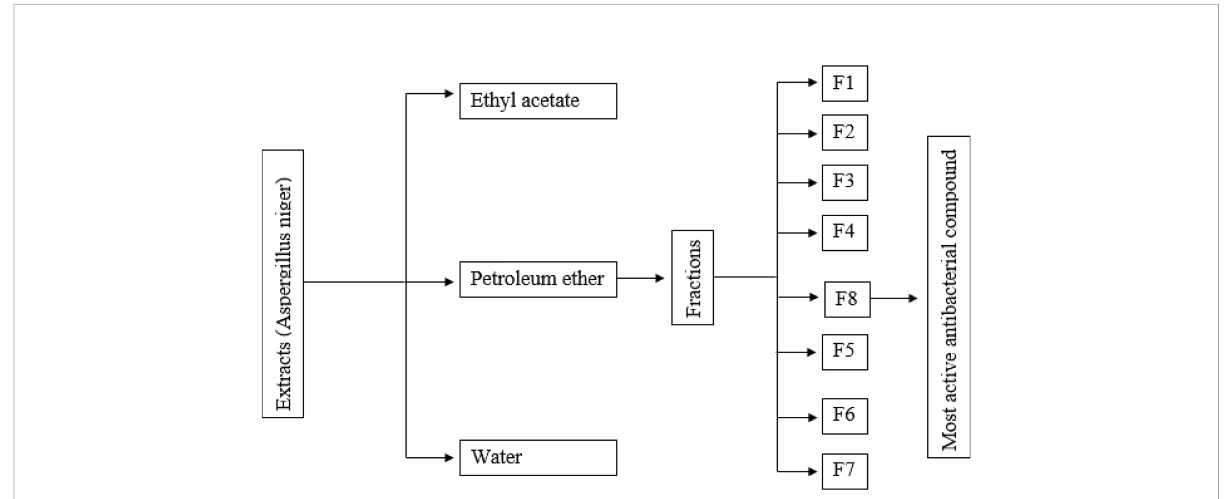
FIGURE 1 Schematic presentation of the isolation of the most active antibacterial